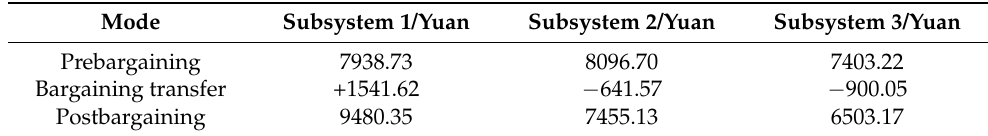
Table 4. Process of each subsystem bargaining under Scenario 4.